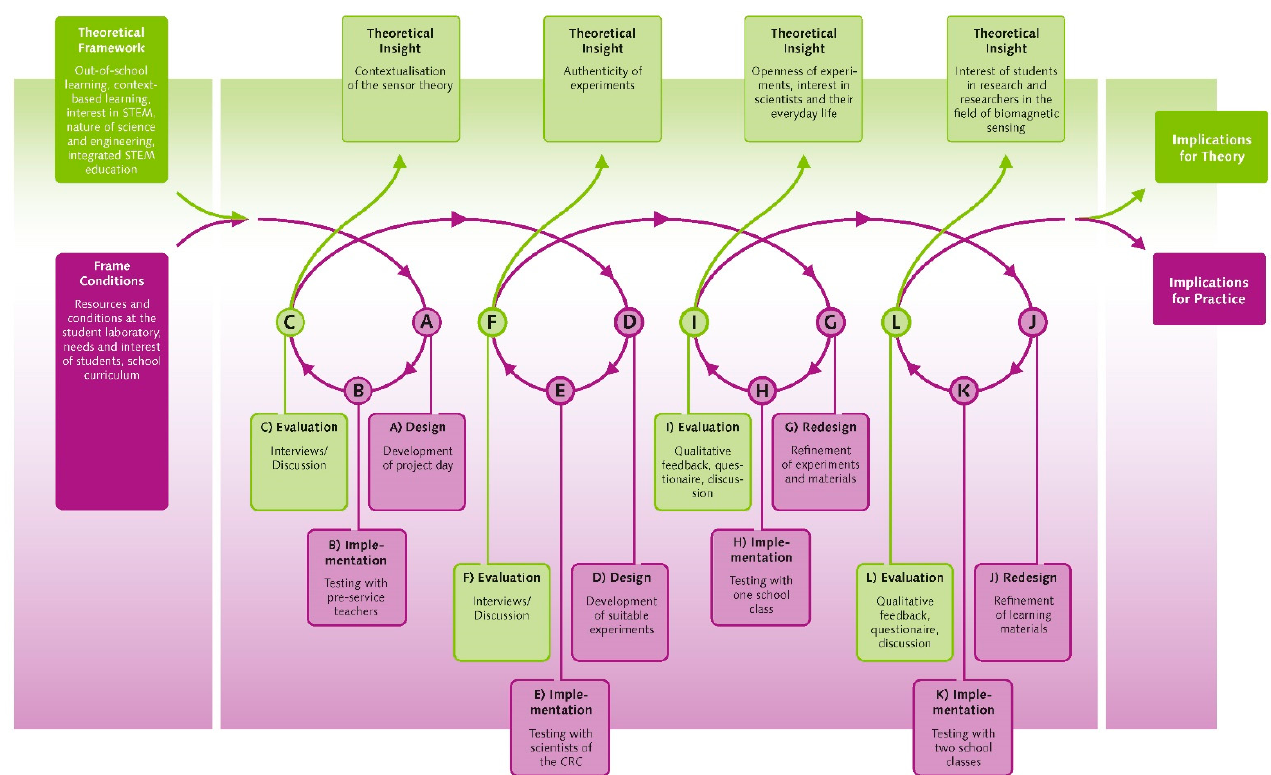
Figure 3. Illustration of the design-based research process that lead to the design of the project day.